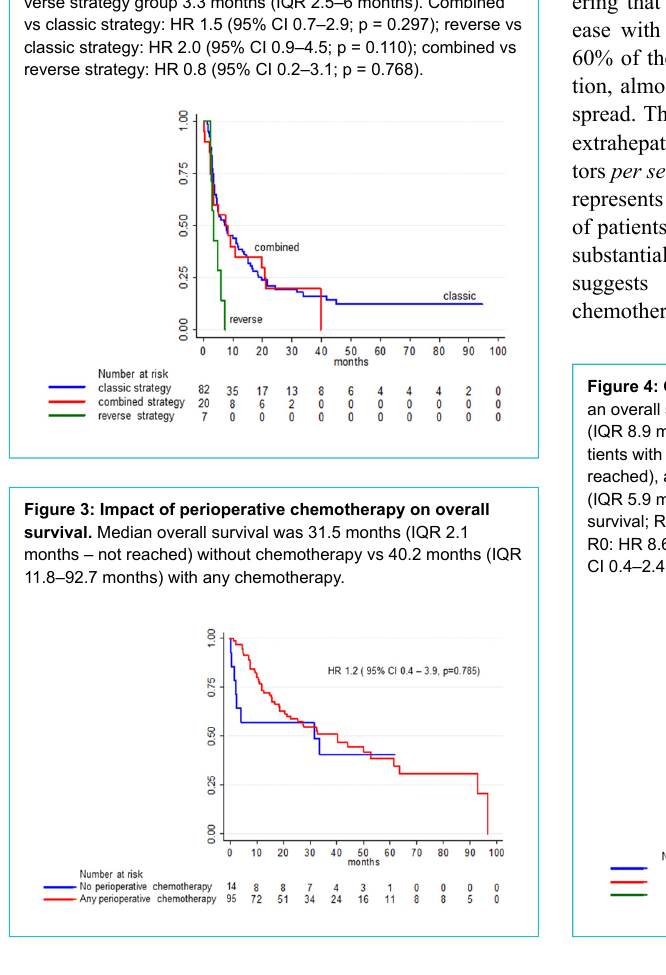
Figure 2: Disease-free survival according to treatment strate- gy. The median disease-free survival was 7.7 months (IQR 3.3–19.6 months) in the classic surgery group, 7.4 months in the combined resection group (IQR 2.3–20.7 months), and for the re- verse strategy group 3.3 months (IQR 2.5–6 months). Combined vs classic strategy: HR 1.5 (95% CI 0.7–2.9; p = 0.297); reverse vs